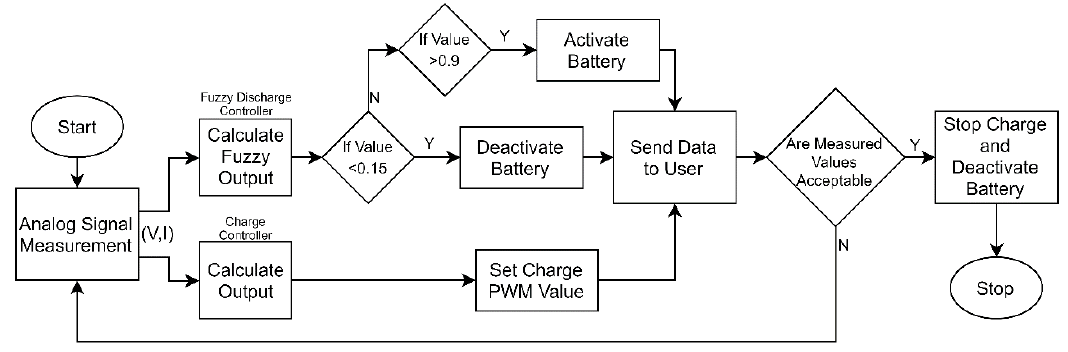
Figure 6. Battery charge/discharge control flow chart.